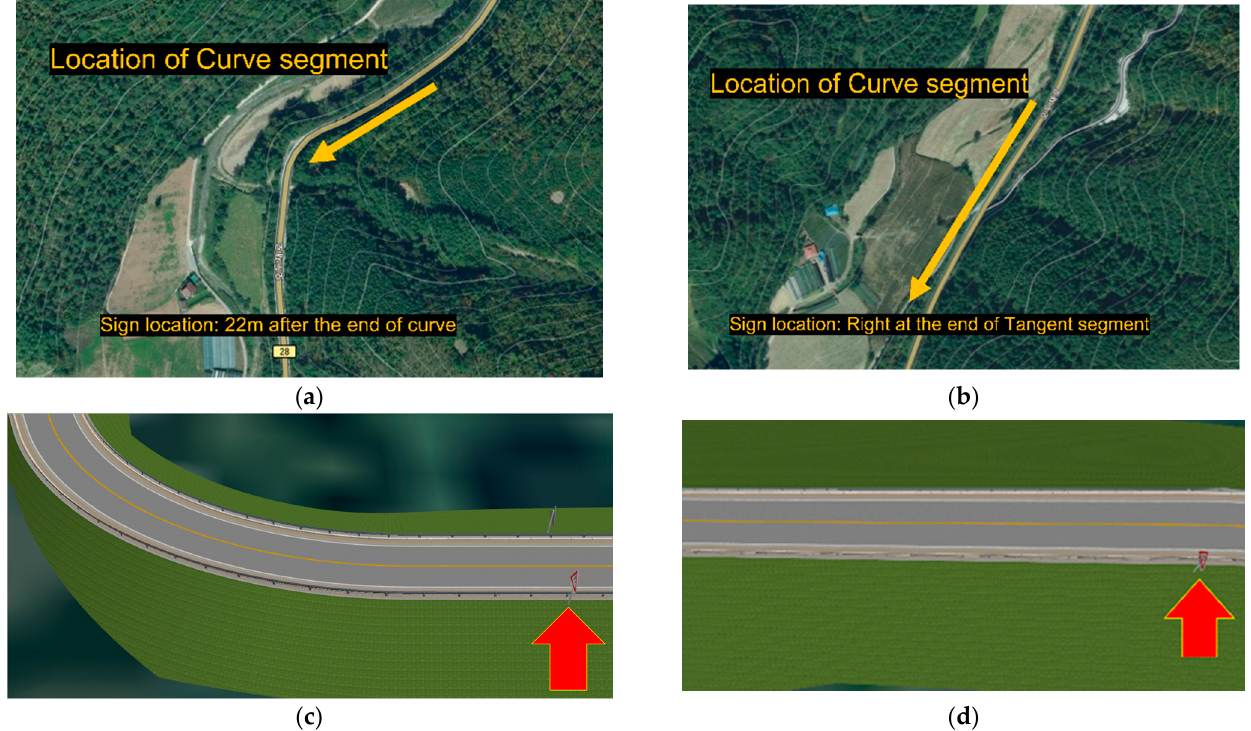
Figure 4. Location of study sites and the signs on the segments for experiments: ( a ) curve segment study site; ( b ) tangent segment study site; ( c ) curve segment in experiments; ( d ) tangent segment in experiments.